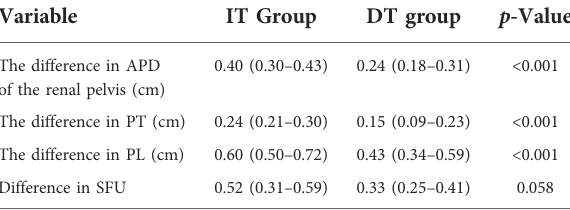
TABLE 2 Preoperative and postoperative changes in renal